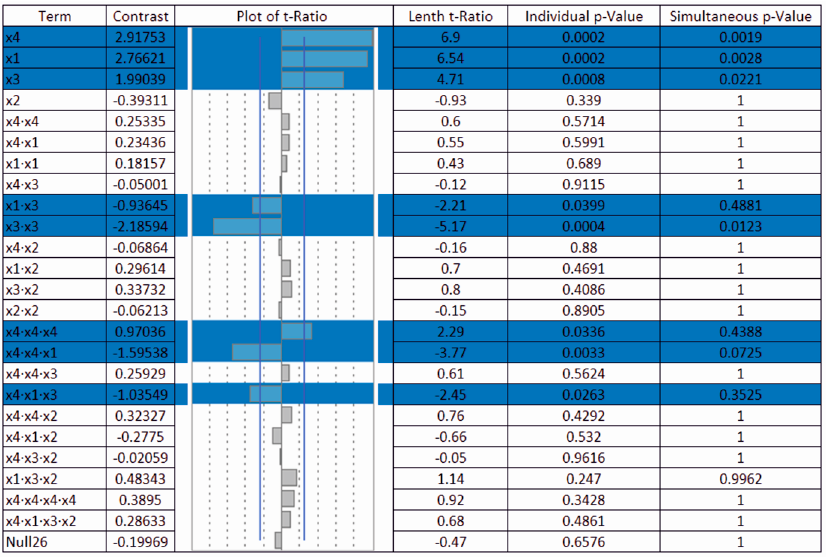
Figure 4. Screening analysis of experimental data for the current density of 5 A · dm − 2 .